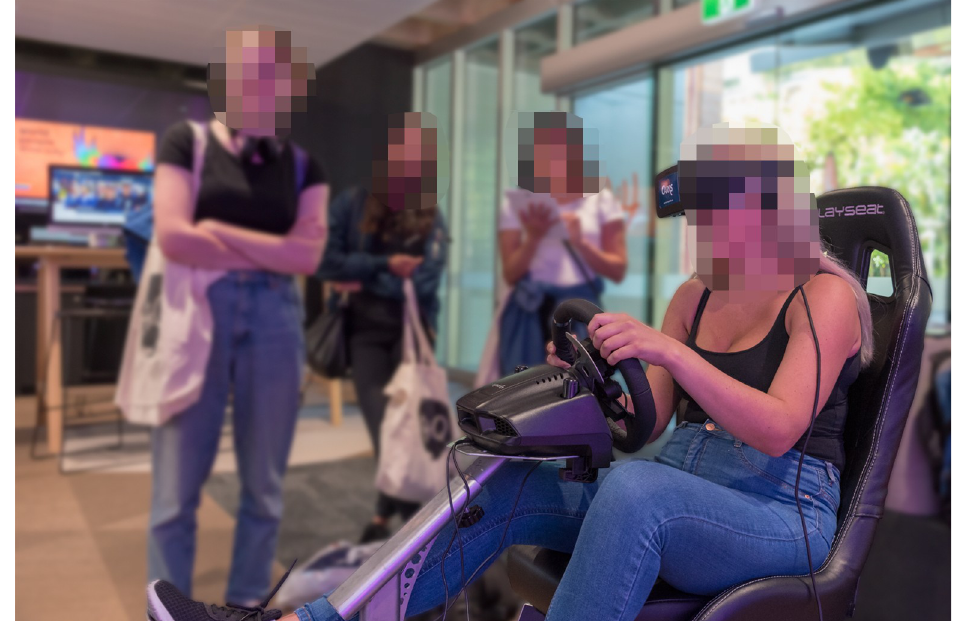
Fig 2. The VR driving simulator, adjusted for a participant’s maximum comfort.